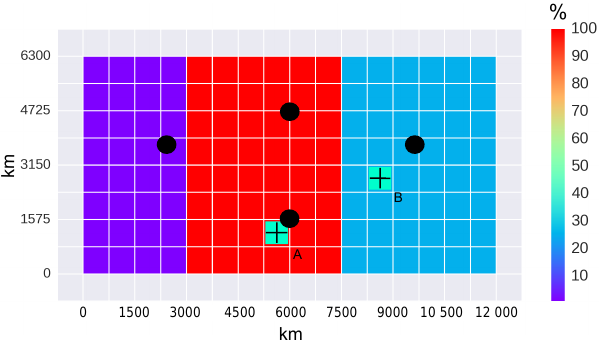
Figure 1. QG-Chem horizontal domain: scaling factor for the chem- ical surface emissions (in colors), location of the synthetic obser- vations used in the assimilation experiments (black circles) and locations for which time series of DA experiments are displayed (crossed boxes A and B). The numerical grid is displayed using white